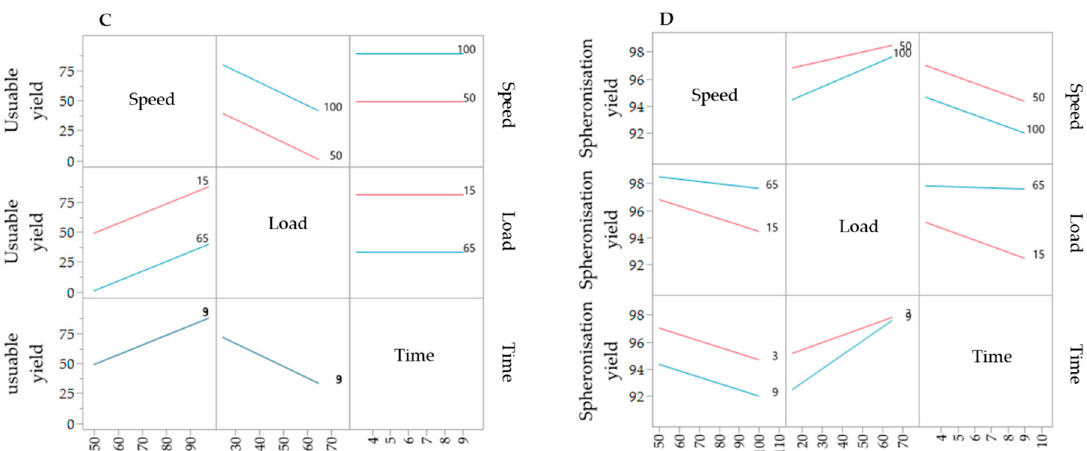
Figure 8. Interaction profiles of the spheronisation process variables rotation time, speed and load on the responses roundness ( A ), roughness ( B ), useable yield ( C ) and spheronisation yield ( D ).